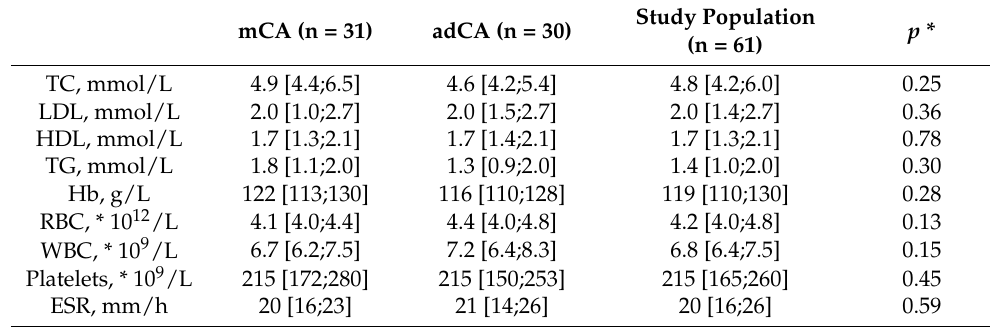
Table 2. Routine laboratory findings in the study